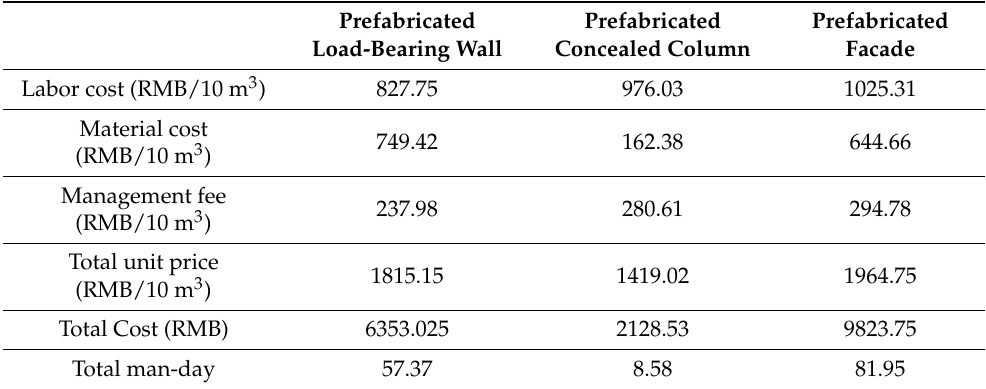
Table 8. Possible rework lifting costs and man-days for 35 m 3 of prefabricated load-bearing walls, 15 m 3 of prefabricated concealed columns, and 50 m 3 of prefabricated facades.